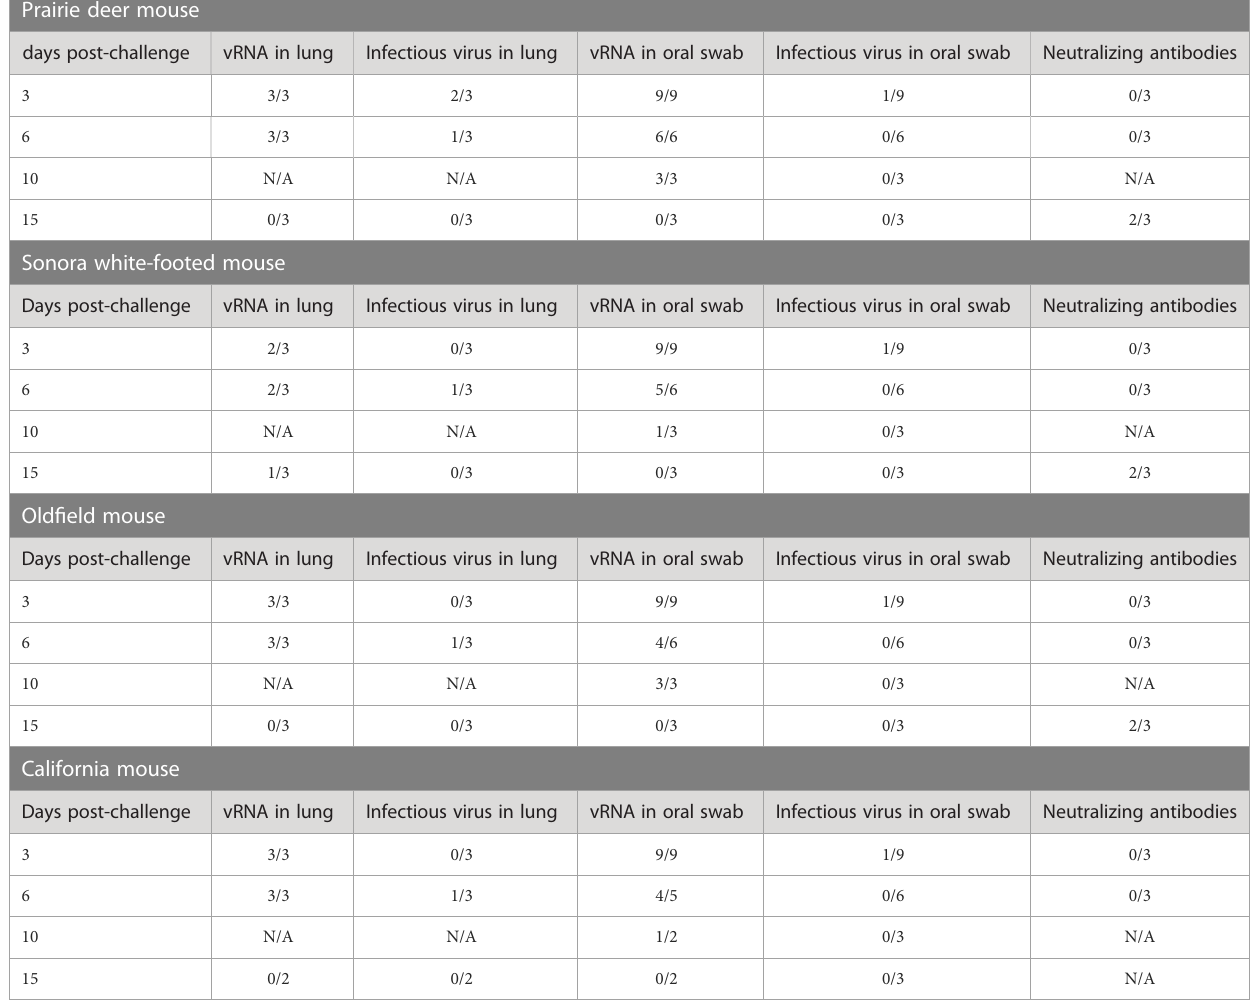
TABLE 1 Detection of viral RNA (vRNA) and infectious virus in lungs and oral swabs and serology. Prairie deer mouse days post-challenge